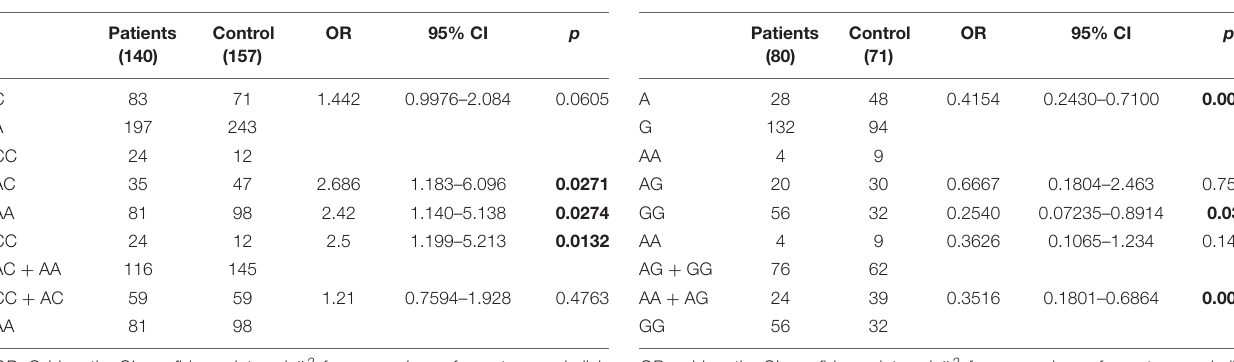
TABLE 4 | Allele and genotype distribution of polymorphisms rs1718119 in the P2RX7 gene in patients with leprosy and controls.